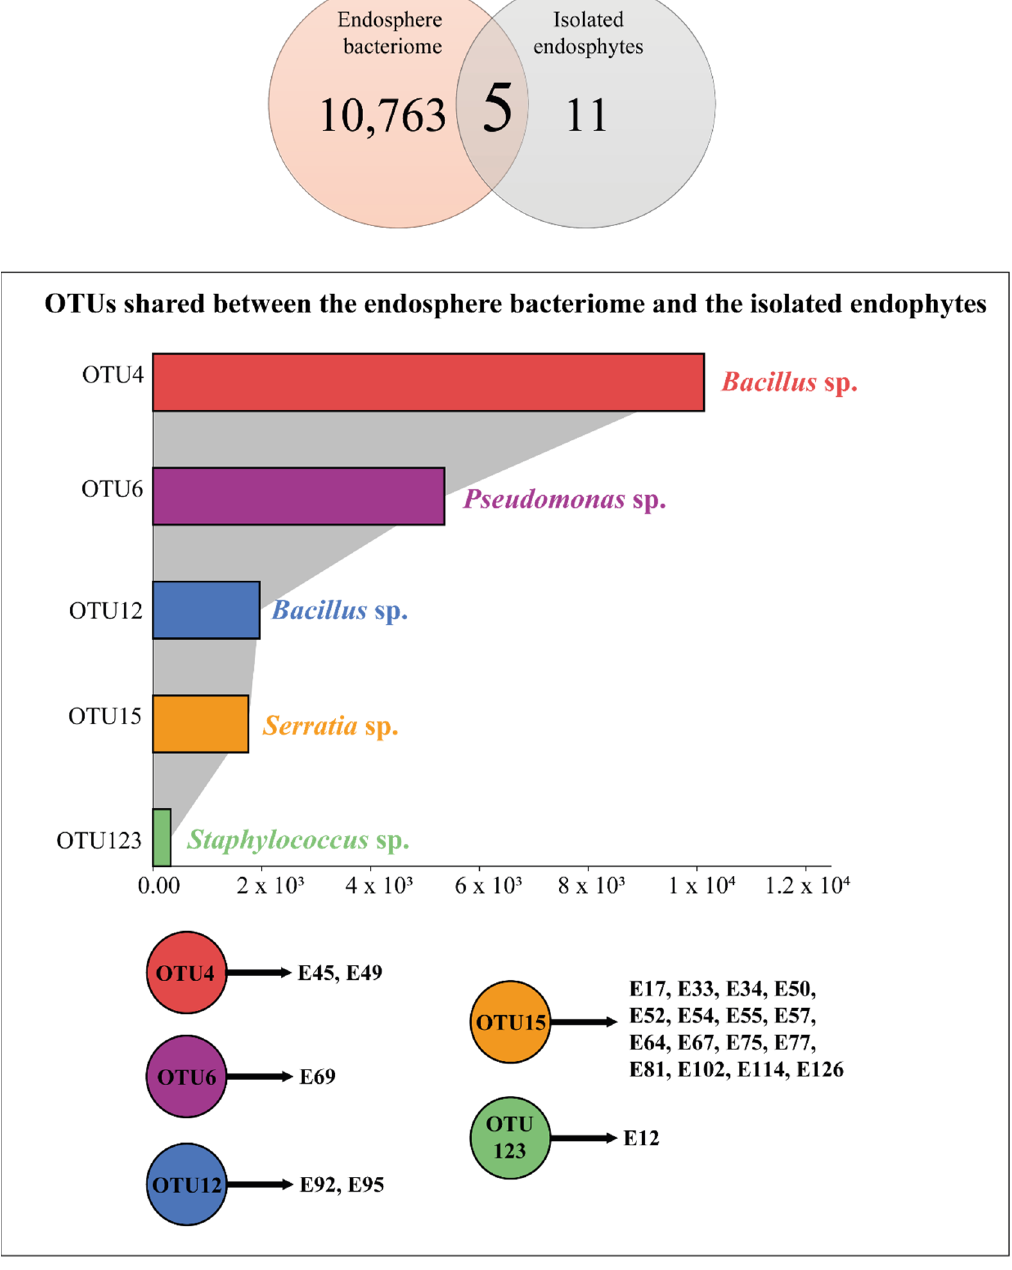
Figure 5. Comparison between the 16S rRNA sequences obtained from endosphere amplicon metagenomic sequencing and the sequences from the isolated endophytic PGPB. The five OTUs shared, as well as their identification at the genus level and the total number of sequences of each OTU, are detailed. The endophytic bacterial sequences clustered within the five OTUs are also listed.